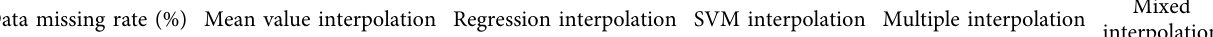
Mixed interpolation